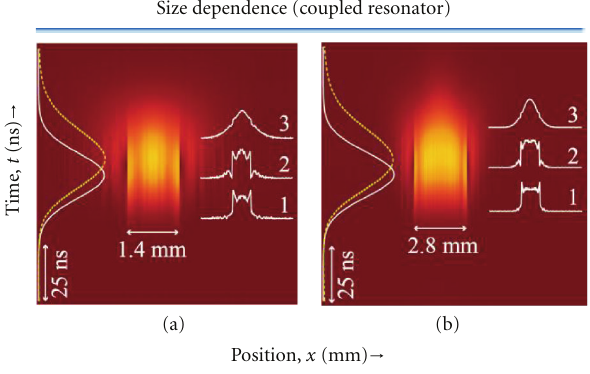
Figure 5: (a) and (b) Reflected images from the coupled resonator for di ff erent image sizes. The sizes of the images used in (a) and (b) are 1.4 mm and 2.8 mm, respectively, the full widths of the Fourier images are δk = 5 . 5mm − 1 and δk = 2 . 7 mm − 1 , respectively, and the spatial bandwidth of the cavity is Δ k = 9 . 0 mm − 1 . The notations 1, 2, and 3 correspond to the earlier, intermediate, and later time profiles, respectively, in both figures. In both cases, the cavity parameters ( R 1 = 0 . 5, R 2 = 0 . 9, R 3 = 0 . 99, L 1 = 5cm, L = 10cm) are the same as those used for the simulations shown 2 in Figures 3(f) and